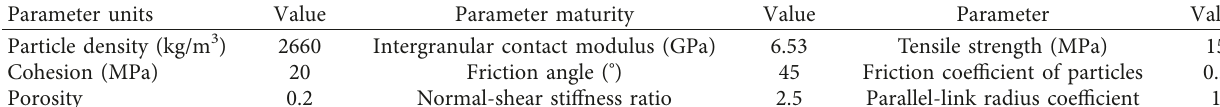
Table 1: Microscopic parameters of the granite particle model [43].